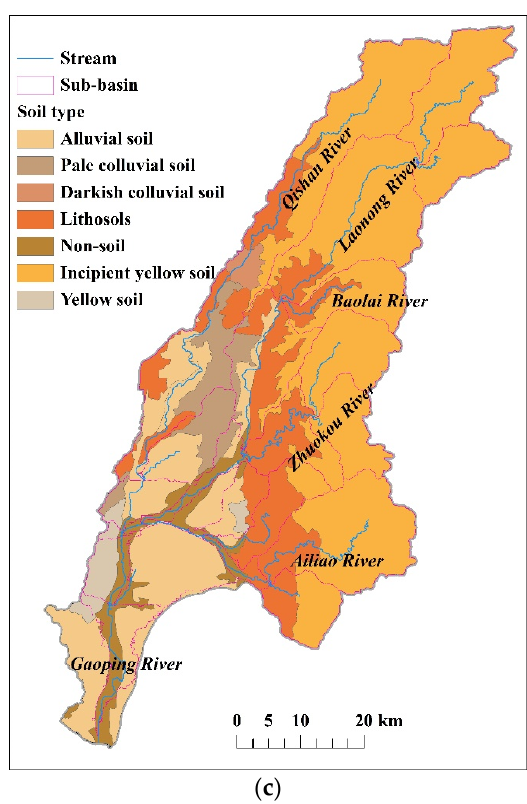
Figure 1. Geographical maps and geological settings of the Gaoping River Basin (GRB), ( a ) digitalized surface elevation; ( b ) lithological units and ( c ) soil